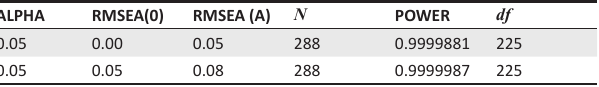
TABLE 7: Power assessment for the structural model for the tests of exact and close fit. ALPHA RMSEA(0) RMSEA (A) N